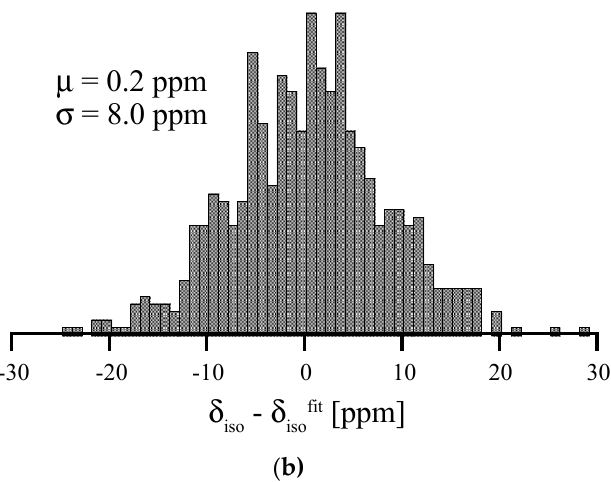
Figure 10. ( a ) Correlation between 29 Si δ iso and average Si-N bond length for Si [4] without a fifth N within 2.8 Å. Red dots and line depict the correlation obtained for scaling crystalline β -Si 3 N 4 . ( b ) Histogram of deviations of data points of amorphous Si 3 N 4 from the correlation line β -Si3N4 (“Residual”).